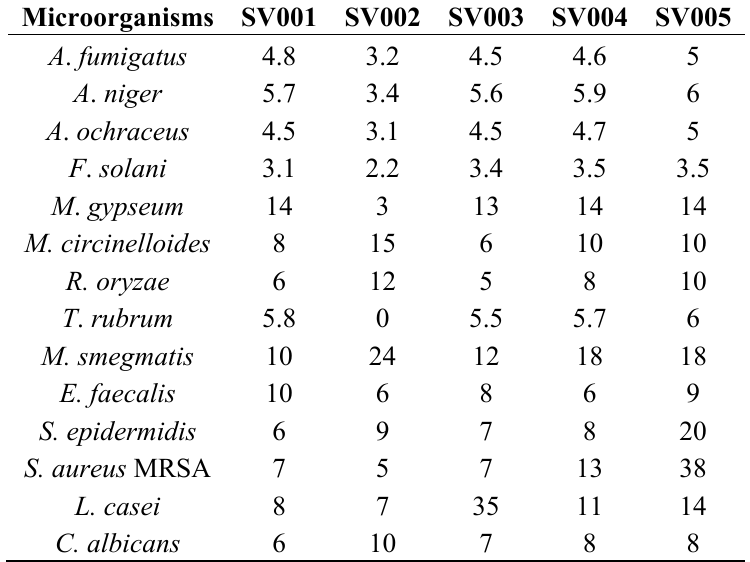
Table 2. Inhibition zones (in mm) for C. cajucara essential